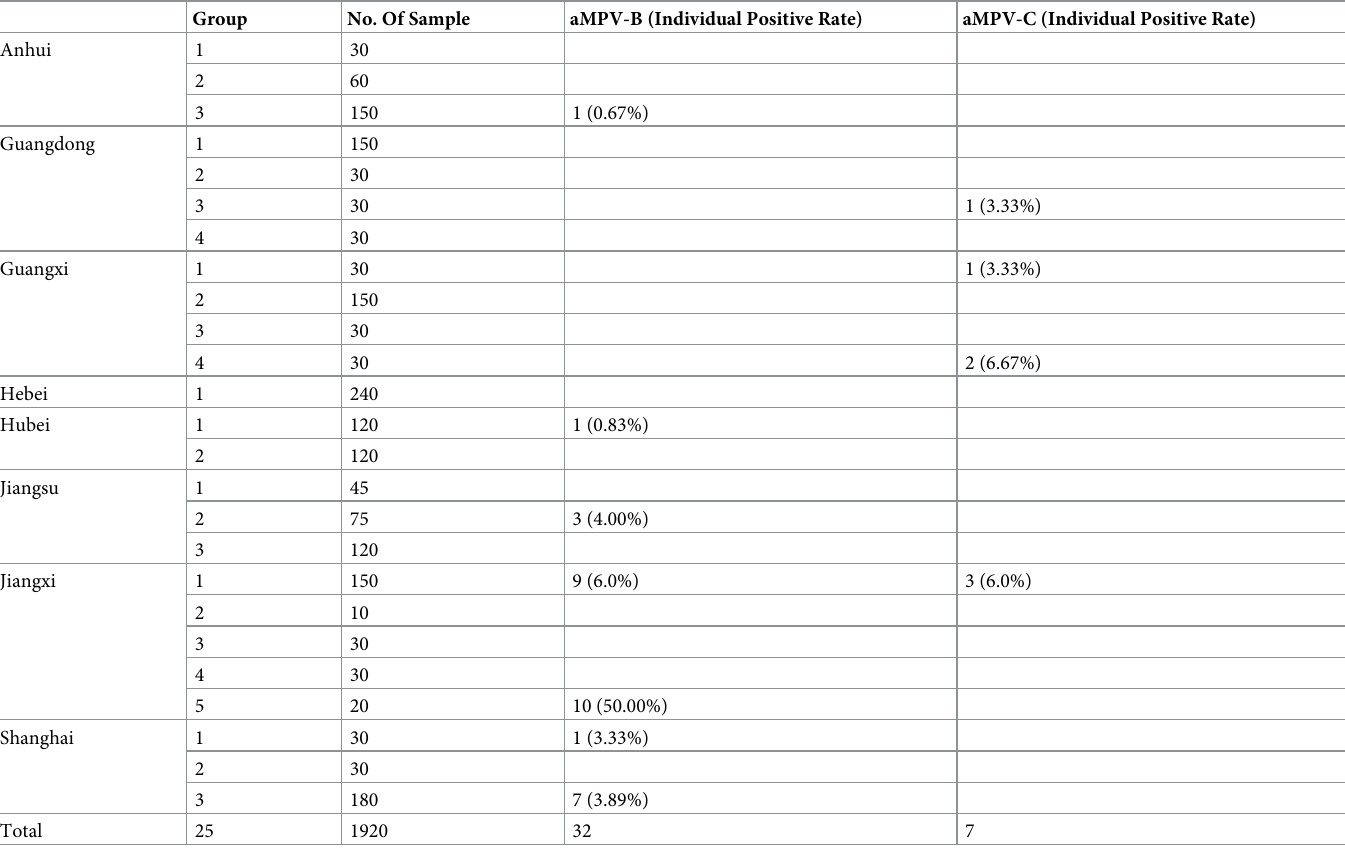
Table 5. The distribution of 39 positive samples in each live poultry market. Group